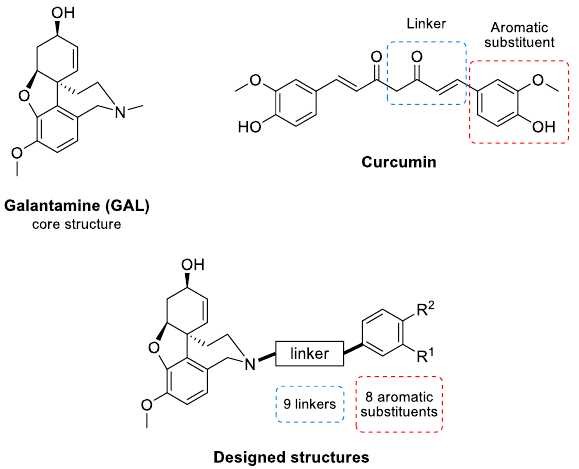
Figure 1. Common structure of the designed GAL-CU hybrid molecules.